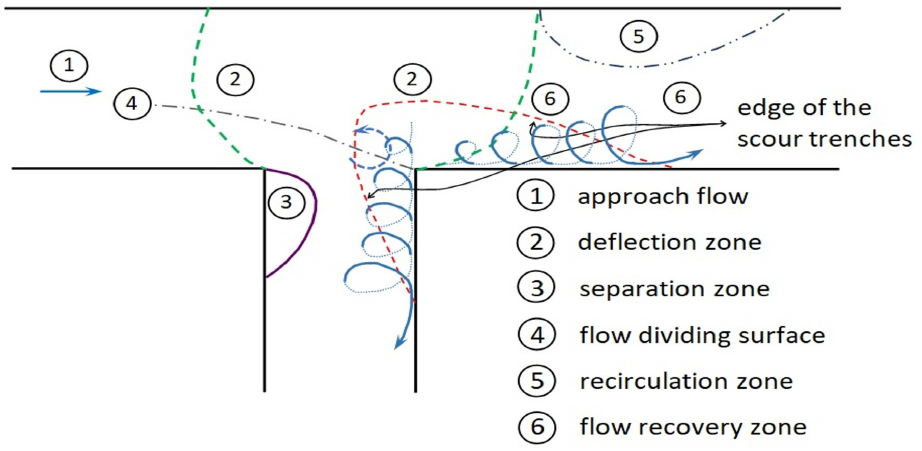
Figure 7. Schematic of the flow hydrodynamics at a 90 ◦ diversion. Reaching the vane-field, at x = − 0.36 m (Figure 8f), the flow was altered when com- pared with the flow in the most upstream cross-sections of the VF case, with a circulation created around the vanes. At x = − 0.36 m, the streamwise velocity, u , also decreased significantly close and slightly below to their tips. Near the vertical surface of the inner vane facing the inner wall, the crosswise velocity component, v , decreased and the vertical component, w , increased in magnitude and pointed downwards (Figure 8f), as reported by Firozjaei et al. [15]; in the vertical profiles between the two vanes, the ( v , w ) velocity components pointed to the outer vane, leading to the appearance of the tip vortex referred to by Barkdoll et al. [6] on the tip of that vane. The downflow created near the vanes for z < 0.03 m was most likely responsible for scouring around them.